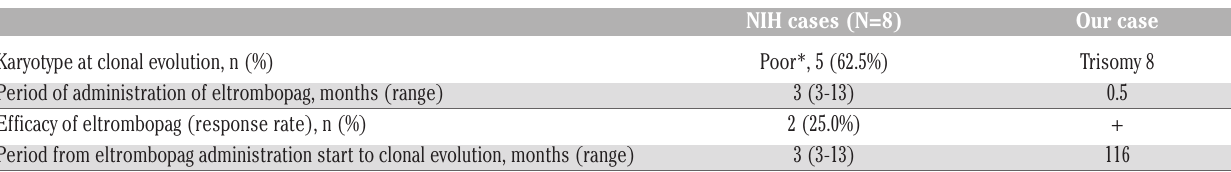
Table 1. Comparison between NIH cases and our case.